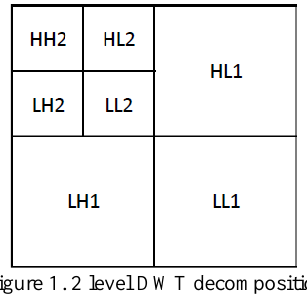
Figure 1. 2 level DWT decomposition